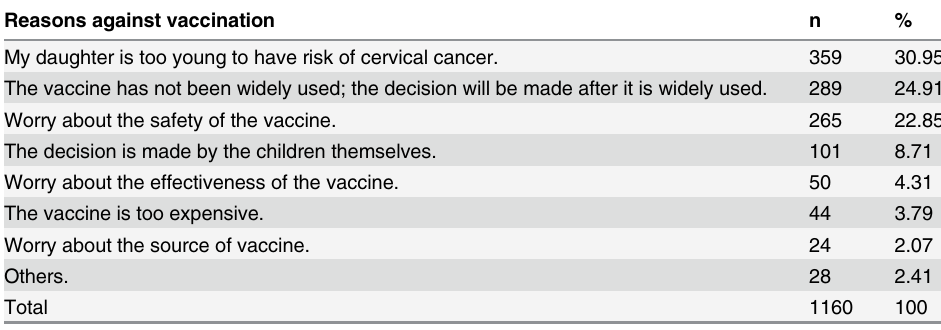
Table 6. The reasons against vaccination for daughter. Reasons against vaccination n